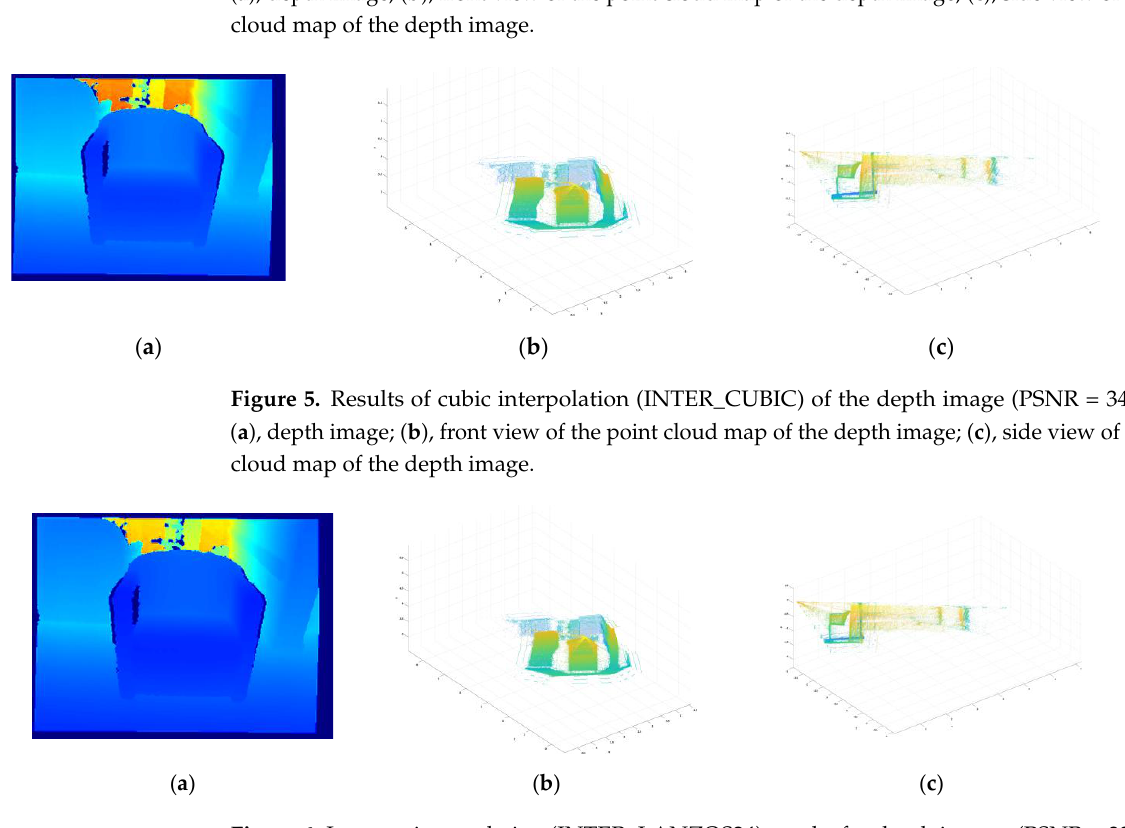
Figure 6. Lanczos interpolation (INTER_LANZOS24) results for depth images (PSNR = 33.654 dB). ( a ), depth image; ( b ), front view of the point cloud map of the depth image; ( c ), side view of the point cloud map of the depth image. Table 1. Comparison of classical interpolation algorithms.